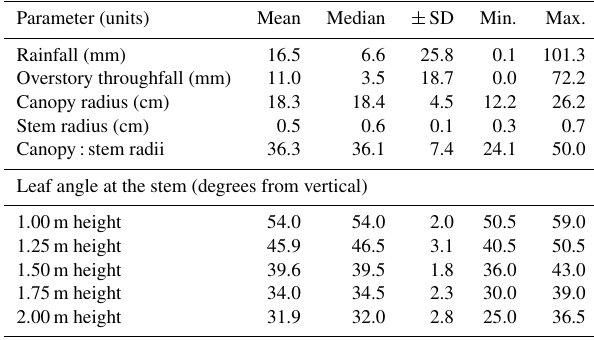
Table 1. Descriptive event statistics for rainfall (observed), over- story throughfall (estimated per Fig. 3) and measured individual plant traits. When minimum overstory throughfall was zero, dew occurred – as verified by air temperatures equalling dew point tem-